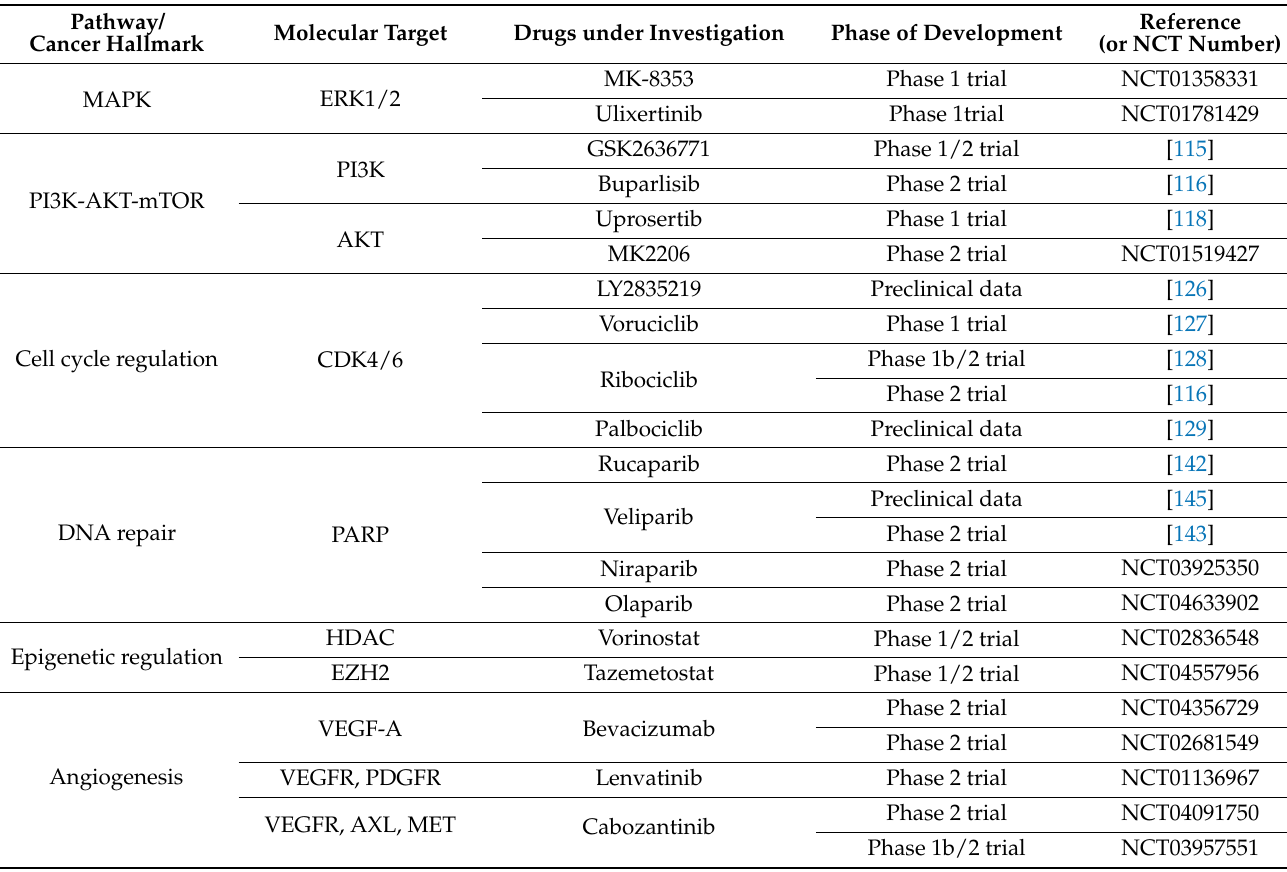
Table 4. New therapeutic targets for BRAF V600-mutant melanoma patients and drugs under investigation. Pathway/ Cancer